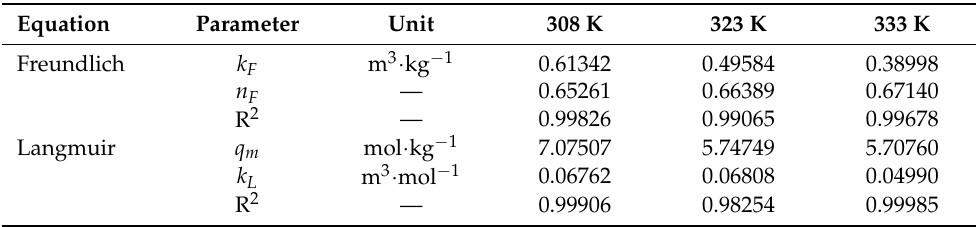
Figure 10. Uptake of AgNO 3 on SBA-15 at ρ = 792 kg · m − 3 and different temperatures; experimental data taken from [59]. Table 7. Adsorption isotherm parameters for AgNO 3 from scCO 2 solution on SBA-15 at ρ = 792 kg · m − 3 and different temperatures